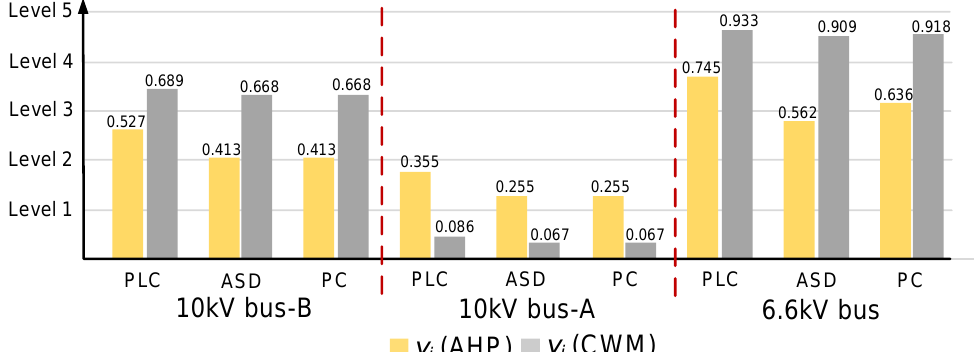
Figure 8. Voltage sag severity level of THPSF.